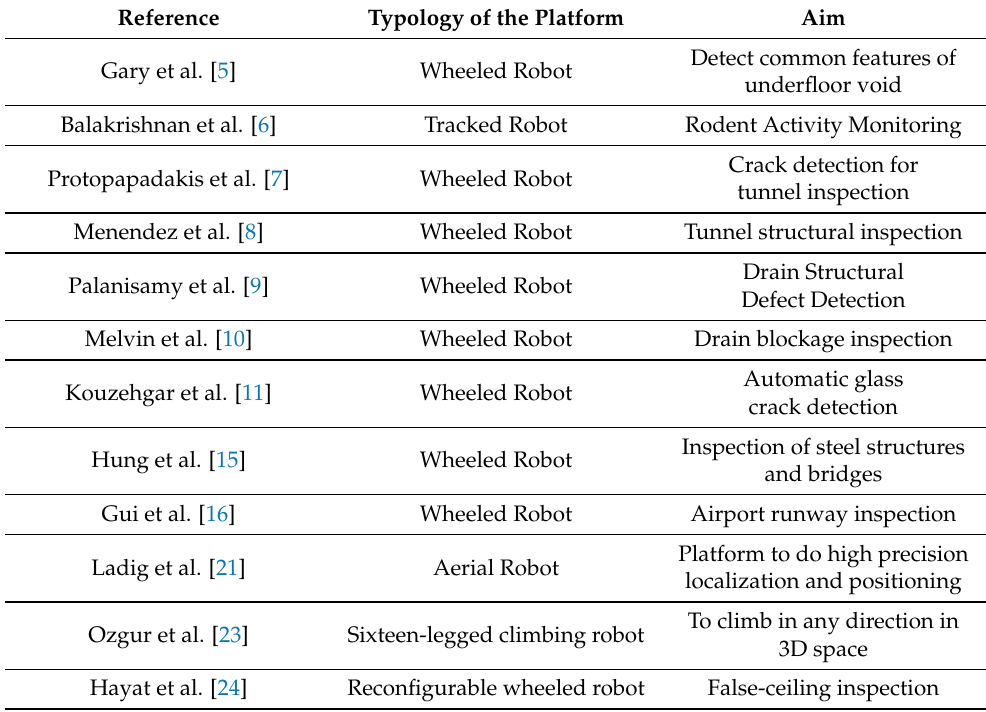
Table 1. Summary of